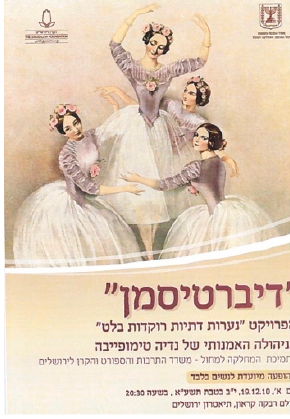
Figure 2. Original Pas de Quatre Print.